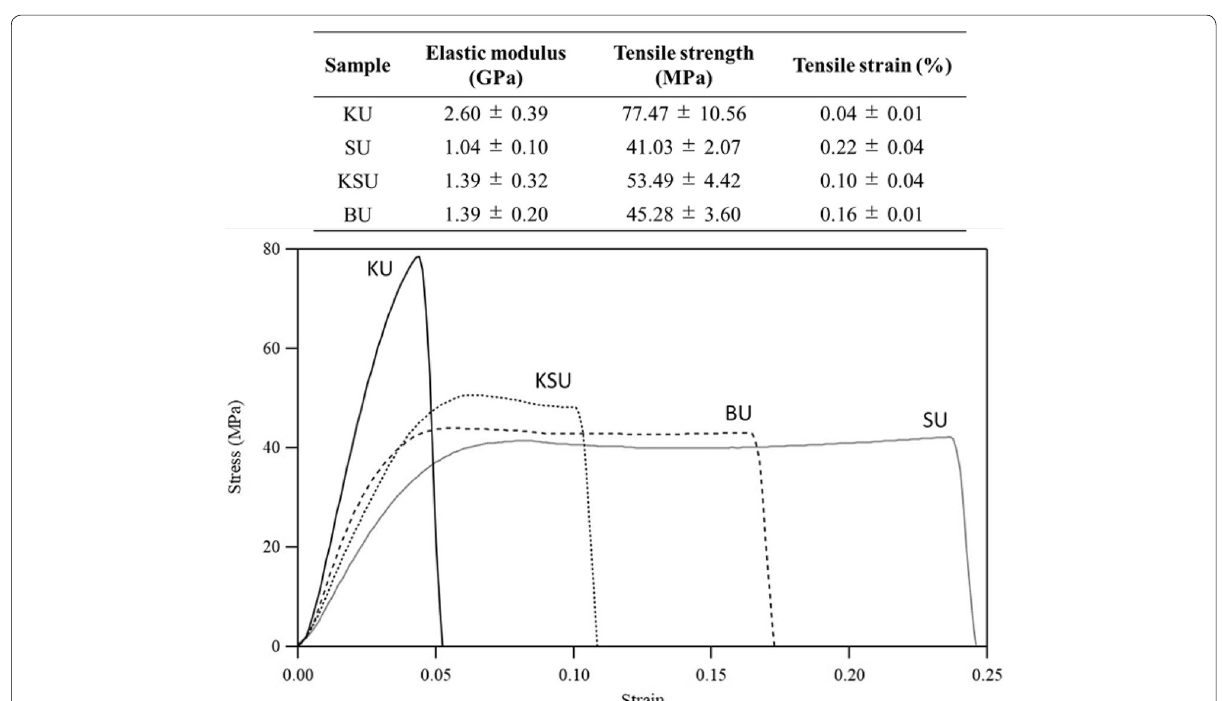
Fig. 6 Elastic modulus, tensile strain, and tensile strength, and stress–strain curve of each urushi film (mean